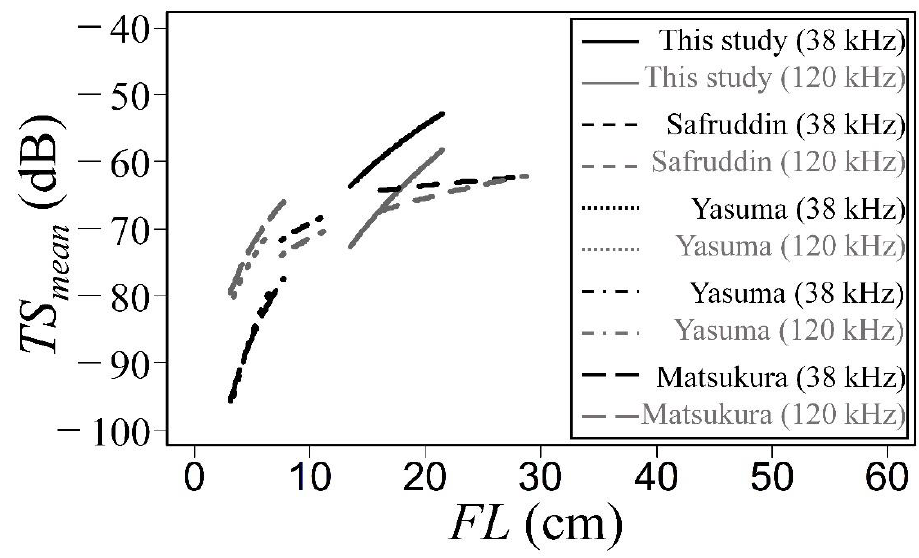
Figure 5. Estimated TS mean —body length relationship of sandeels from the literature and this study. FL was used in this study and SL was used in previous